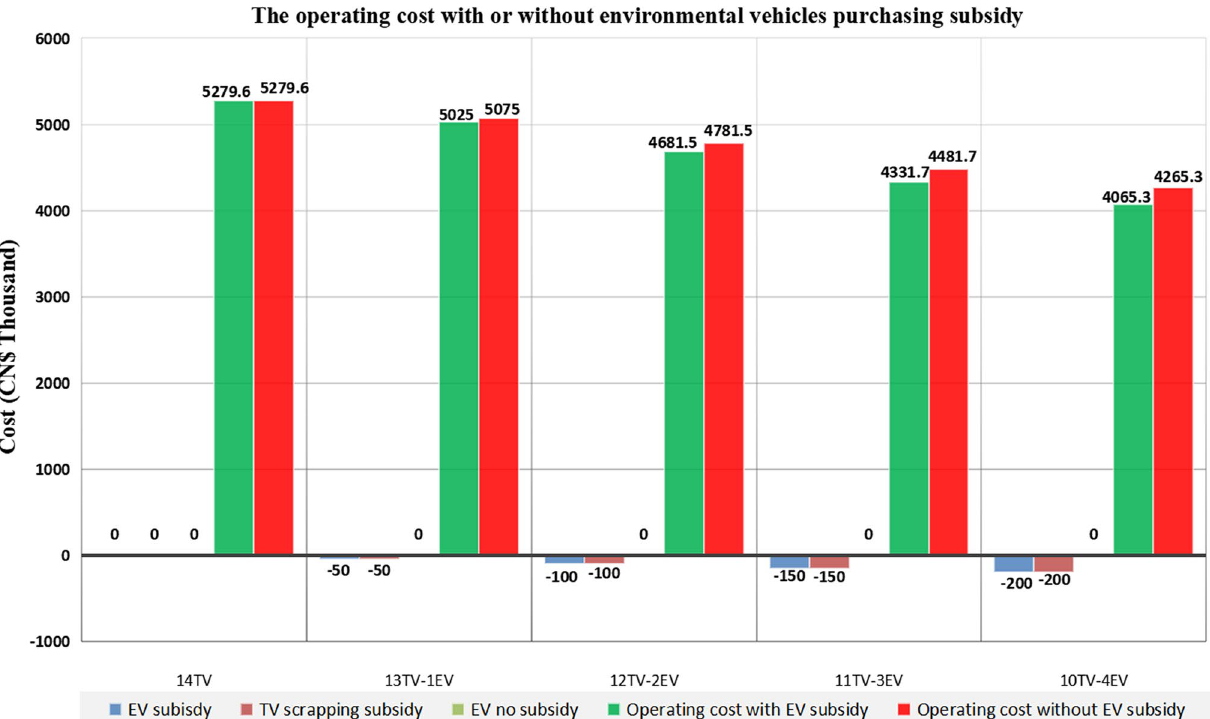
Figure 7. Changes in subsidy for the purchase of environmental vehicles. The results in this figure mainly compare the operating cost with or without environmental vehicles purchasing